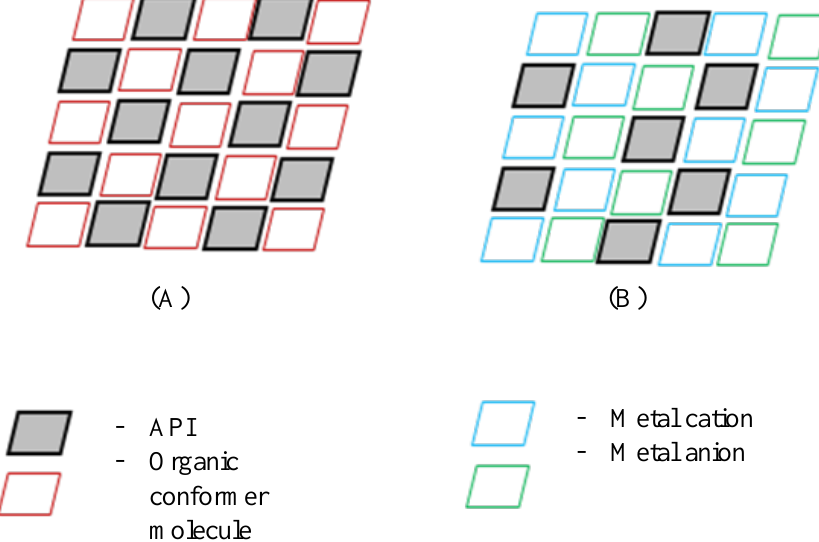
Figure 17. Schematic representation of ( A ) a pharmaceutical cocrystal where the API and coformer are organic molecules and ( B ) an ionic cocrystal which contains an organic molecule and a metal ion.